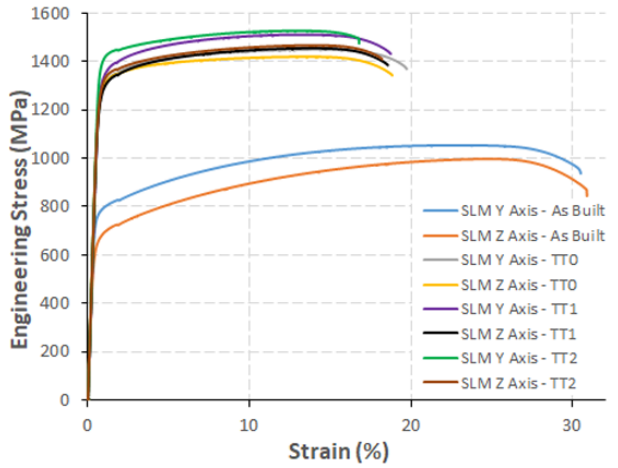
Figure 16. Engineering stress–strain curves for SLM samples in different conditions.